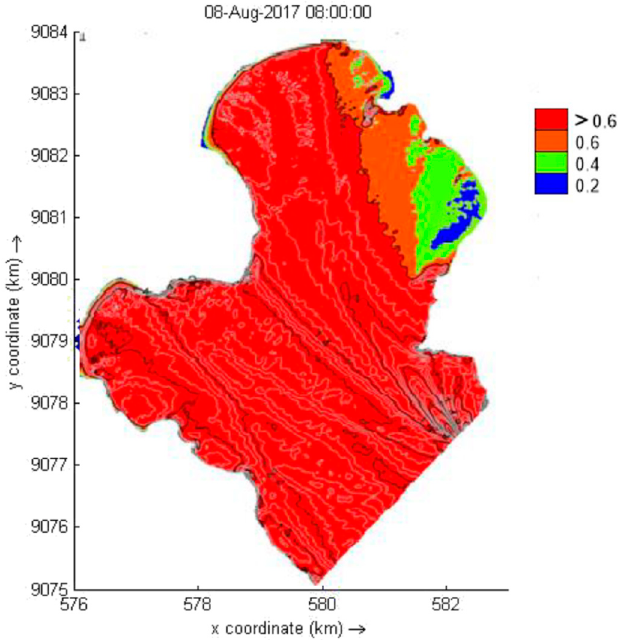
Figure 11. Results Overlay Modeling of Wave 12 Months.